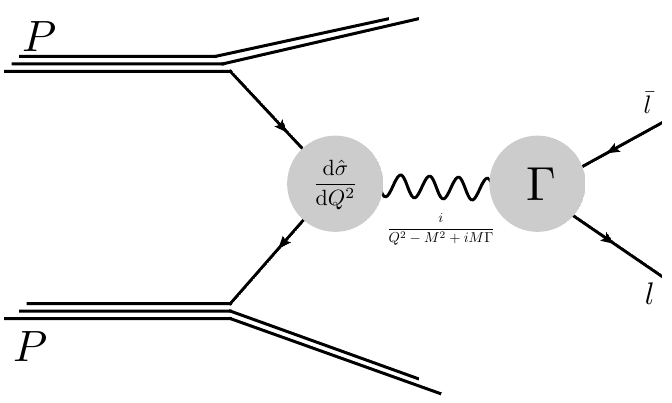
Figure 1. Schematic depiction of the Drell-Yan process and its factorisation into the production probability of a virtual gauge boson and the subsequent decay to final-state